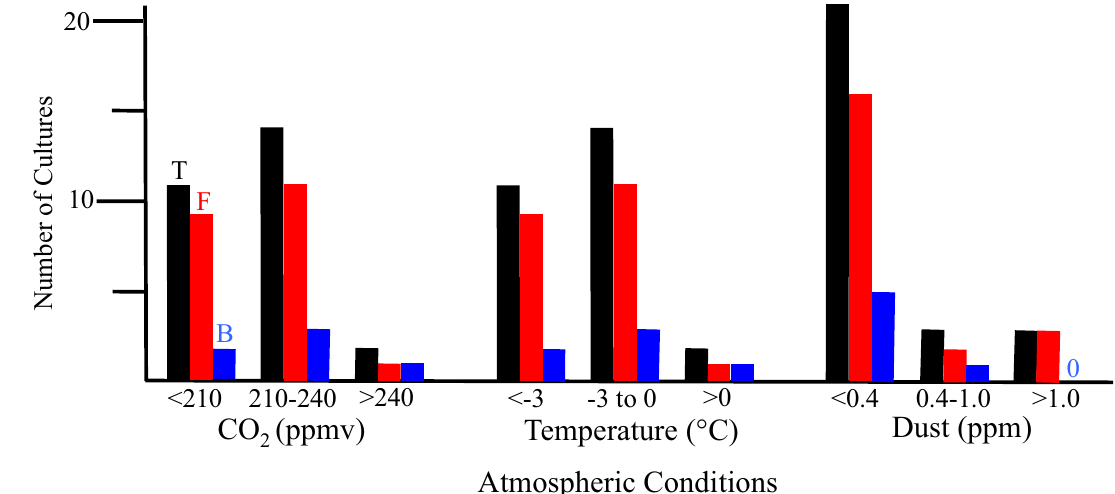
Figure 5. Cultures obtained from ice core sections based on atmospheric conditions at the time of deposition. Black bars indicate total number of cultures, red bars indicate fungal cultures and blue bars indicate bacterial cultures. Values for atmospheric measurements are from reference